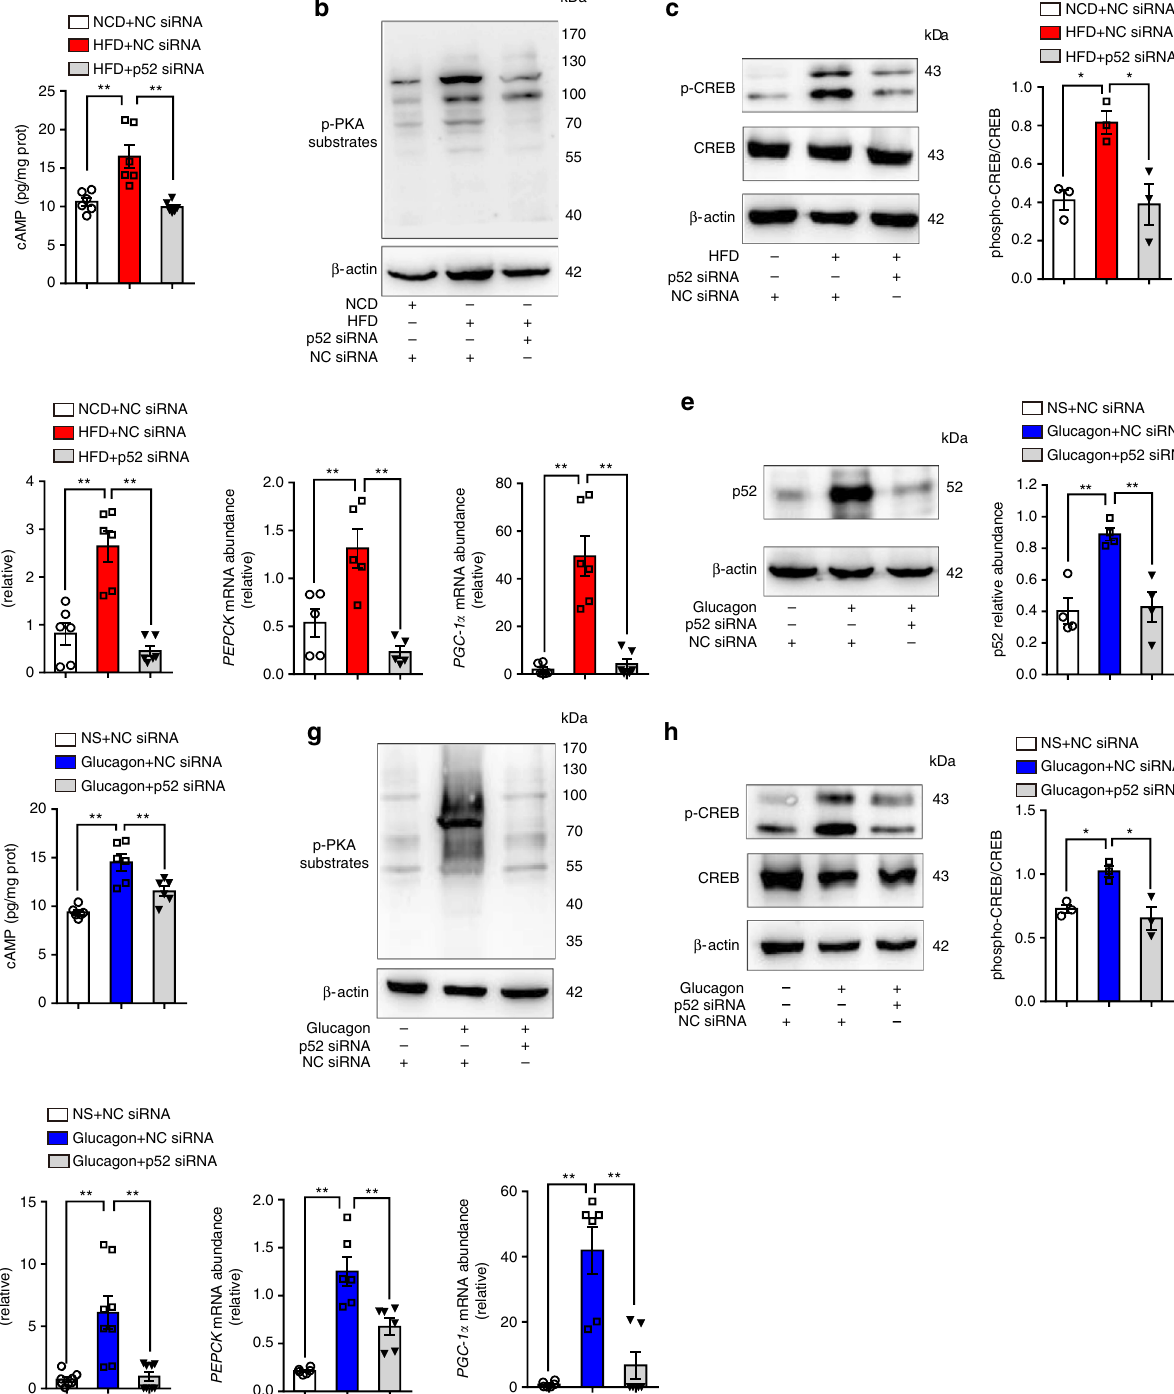
Fig. 2 p52 knockdown blocks cAMP/PKA signaling. a Hepatic cAMP accumulation in the liver tissue of NCD-fed, HFD-fed, and HFD-fed mice with p52 silencing. Liver tissues were collected from the mice after 8 weeks feeding ( n = 6). b , c Western blot analysis of phospho-PKA substrates ( b ) and p-CREB ( c ) expression in the liver tissue from the mice in panel a ( n = 3). d qRT-PCR determination of mRNA levels of G6pase , PEPCK , and PGC-1 α in the livers from the mice in panel a ( n = 6). e Western blot analysis of p52 expression using lysates of the liver tissue from normal mice treated with glucagon (2 mg/kg body weight) and p52 siRNA or NC siRNA ( n = 4). f Hepatic cAMP accumulation in the liver tissue of the mice ( n = 6). g , h Hepatic phospho- PKA substrates and p-CREB protein levels in the mice ( n = 3). i Hepatic mRNA levels of G6pase , PEPCK , and PGC-1 α in the mice ( n = 6). NCD normal chow diet, HFD high-fat diet, PKA protein kinase A, CREB cAMP-response element-binding protein, qRT-PCR quantitative real-time polymerase chain reaction, NS normal saline, G6pase glucose-6-phosphatase, PEPCK phosphoenolpyruvate carboxykinase, PGC-1 α peroxisome proliferator-activated receptor gamma coactivator-1 alpha. Each bar represents mean ± SEM values. Statistical differences were determined by one-way ANOVA. * p < 0.05 vs. the control group, ** p < 0.01 vs. the control group. Source data are provided as a Source Data fi